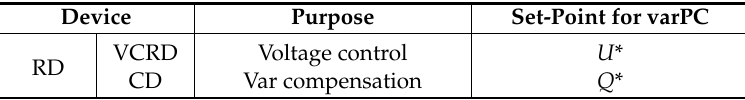
Table 1. Devices considered for voltage-control and var-compensation.